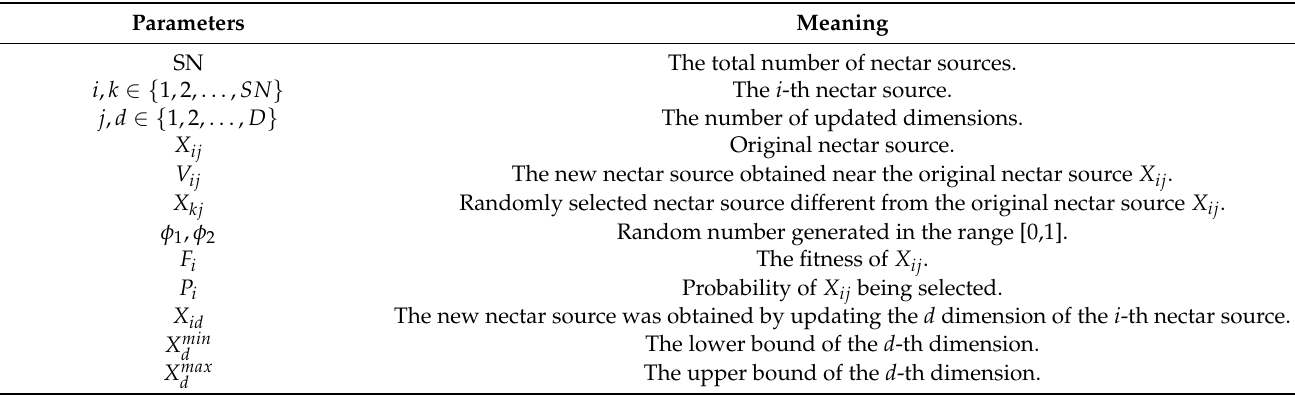
Table 5. Parameters of ABC